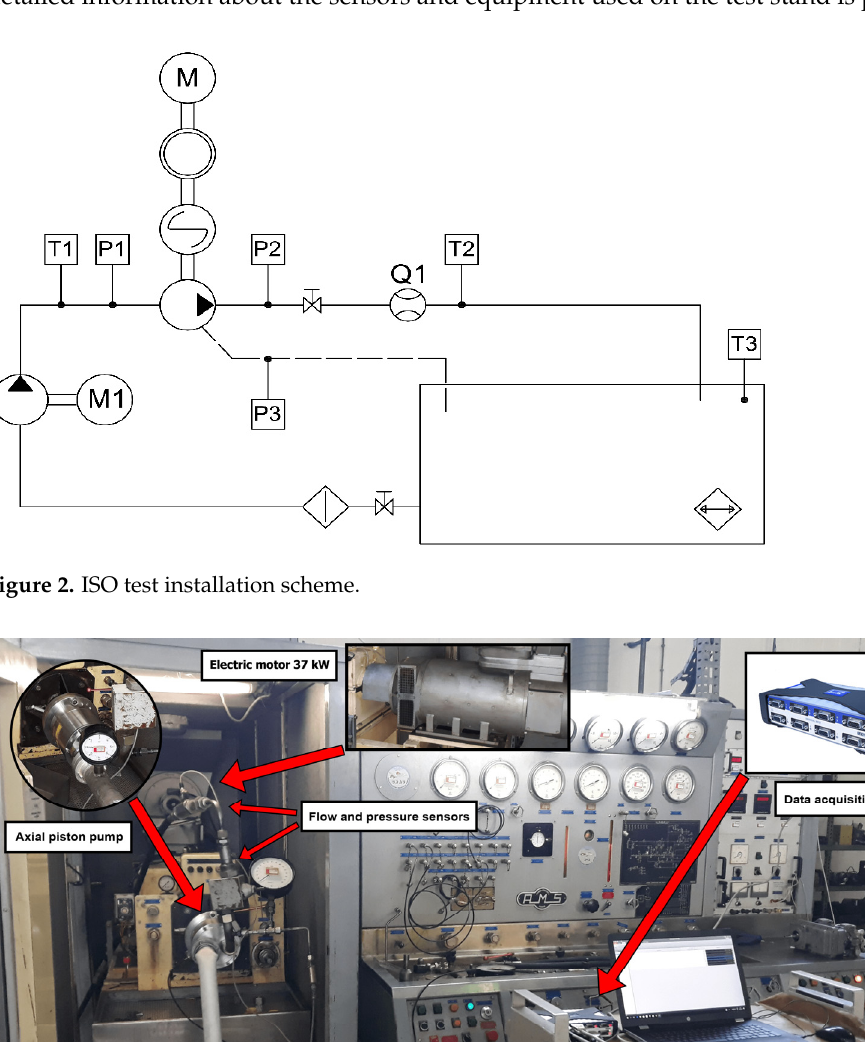
Table 2. Operating modes used during the experimental testing process.